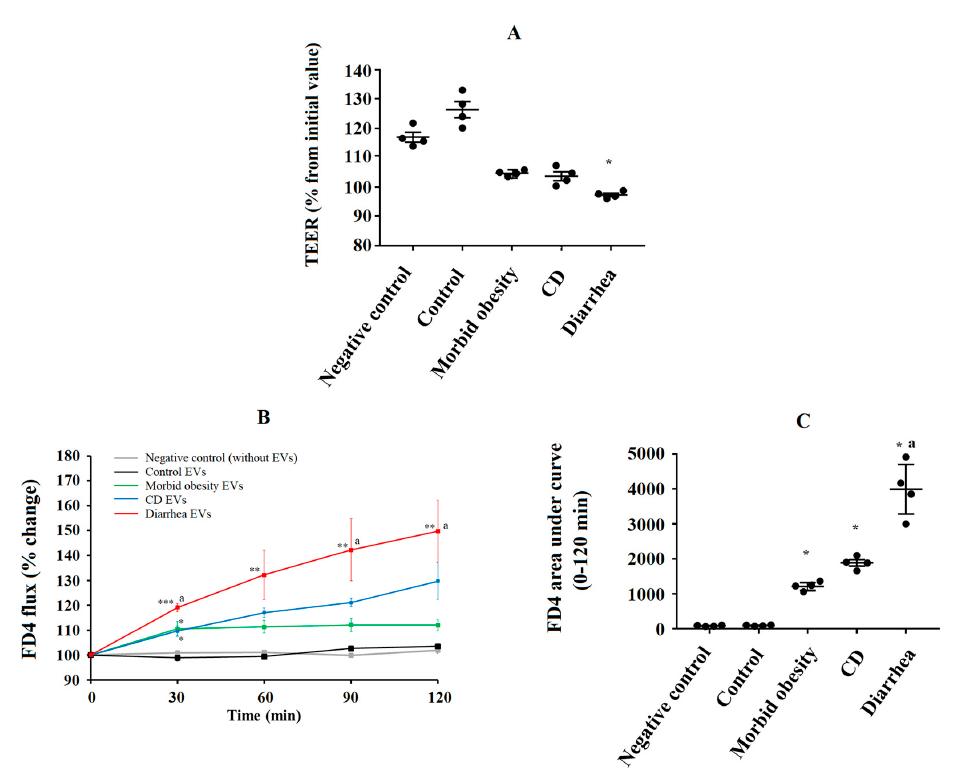
Figure 5. Effect of different types of fecal EVs on the intestinal permeability of Caco-2 cells. Caco-2 cells were plated in 12-well PET Transwell™ inserts of 0.4 µ m pore size (Corning Inc., Corning, MA, USA). A suspsension of fecal purified EVs (n = 4) was added for a 24 h incubation period. After, the alteration of the intestinal permeability of Caco-2 cells was assessed by measuring TEER and FD4 unidirectional flux from the apical to basolateral compartments of the Transwell™ at different time points. A negative control was performed using Caco-2 cells without fecal EV treatment. ( A ) TEER was measured using a Millicell ®® ERS-2 Voltohmmeter (Merck Millipore, MA, USA) by inserting electrodes into the Transwells. TEER values were measured before and after 24 h of incubation with fecal EVs. Data are presented as percentage of change in TEER value from the initial value (before 24 h of incubation). ( B ) After 24 h of incubation with fecal EVs, Caco-2 cells were washed and treated apically with FD4 (1 mg/mL). The fluorescence in the basolateral chamber was measured before and at different times for 2 h after the addition of FD4. Based on relative fluorescence units, data are presented as percentage of change in FD4 concentrations from the initial value (before 2 h of incubation with FD4). ( C ) Area under curve of the increase in FD4 concentration in the basolateral chamber between before and after 2 h of incubation with FD4. * p < 0.05, ** p < 0.01, *** p < 0.001: significant differences with regard to fecal EVs from control patients. a p < 0.05: significant differences with regard to fecal EVs from patients with morbid obesity. All data are presented as means ± SEM.